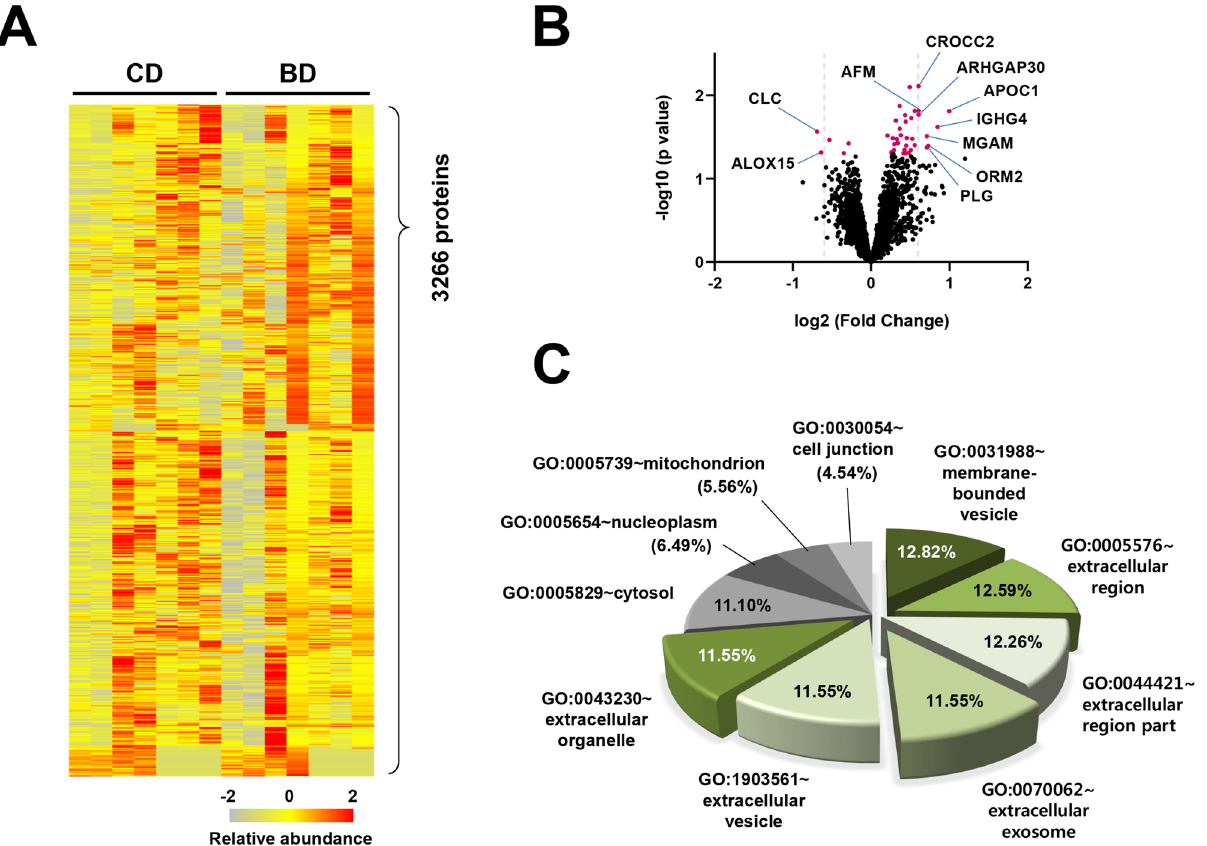
Figure 2. Proteomic characterization of 14 samples (seven from patients with intestinal BD and seven from patients with CD) using TMT-10plex labeling-based quantitative proteomics. ( A ) A heat map showing the relative abundance of 3266 proteins identified across two groups of human intestinal samples. The color key indicates the relative abundance of each protein (− 2 to 2) across 14 samples. ( B ) Volcano plot demonstrating fold changes in protein abundance between intestinal BD and CD. The x -axis represents the log2 ratio, and the y -axis represents significant differences (-log10 of p value). Proteins showing significantly altered expression ( p < 0.05) are colored in magenta, and include the top ten up- or down-regulated proteins (fold change > 1.5). ( C ) A pie diagram showing cellular localization of human colon mucosa proteomes classified by the top ten cellular compartments in functional annotation with gene ontology (GO) with secretion-related proteins highlighted in